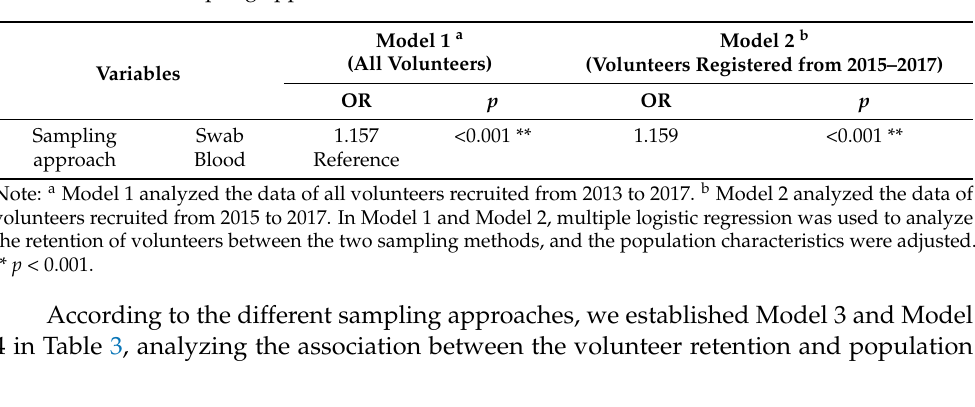
Figure 3. HSCD volunteer retention rate by registration year.